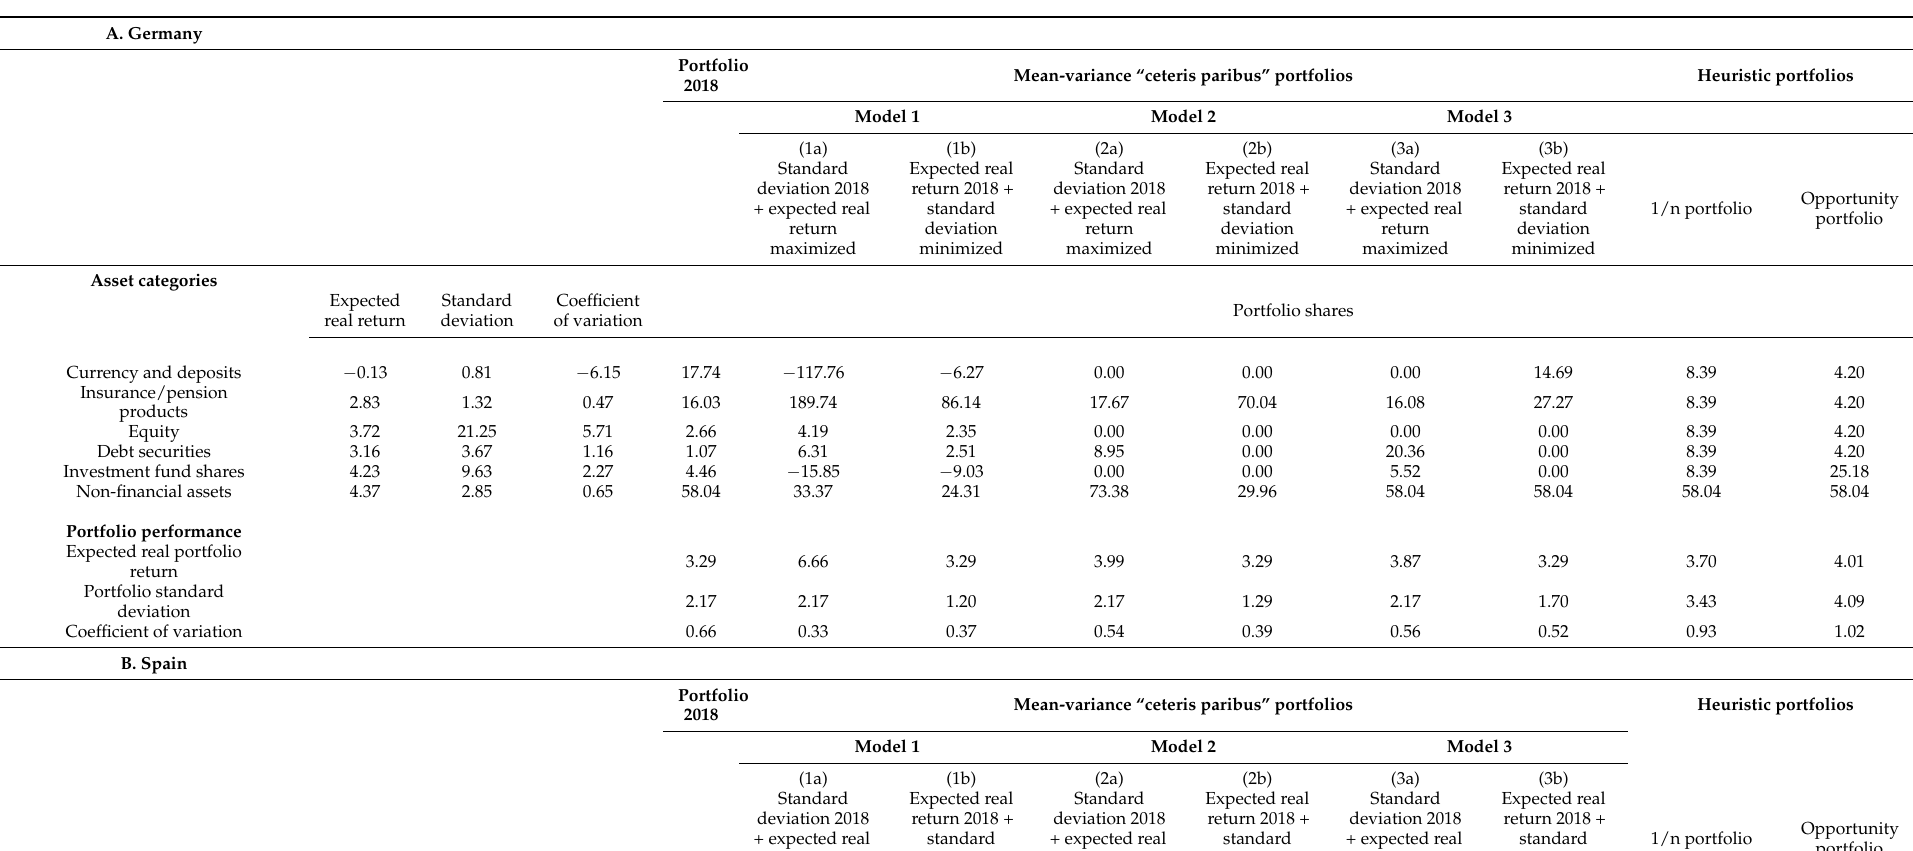
Table 5. Mean-variance “ceteris paribus portfolios” and heuristic